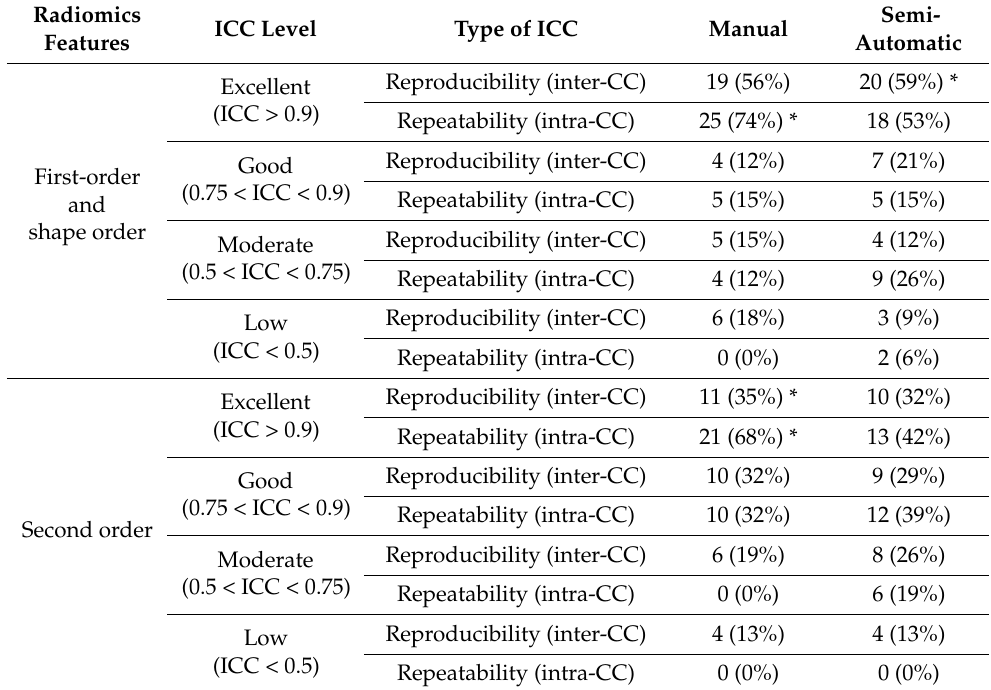
Table 3. Comparison of reproducibility and repeatability of Manual and Semiautomatic Segmentation based on ICC levels (* shows the highest % for excellent